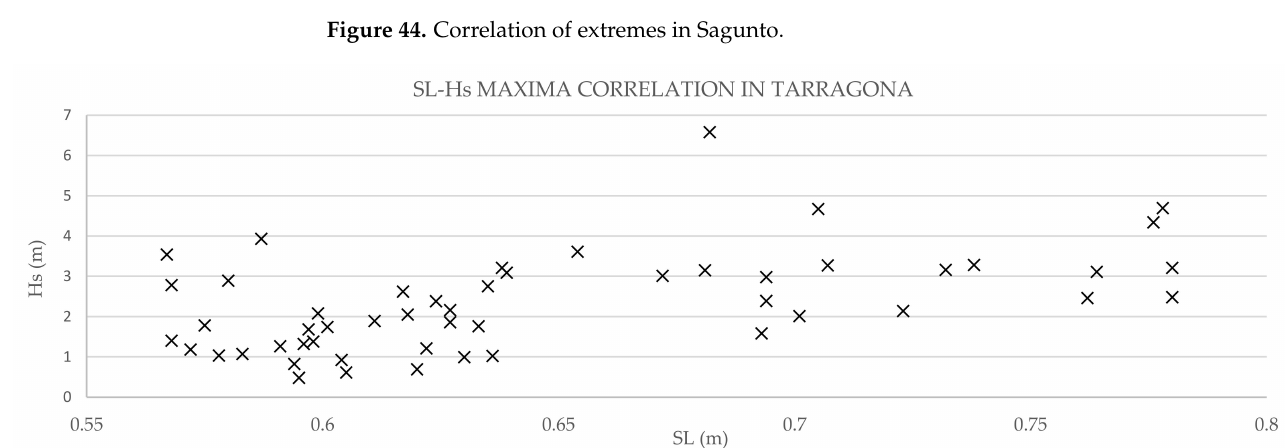
Figure 45. Correlation of extremes in Tarragona.